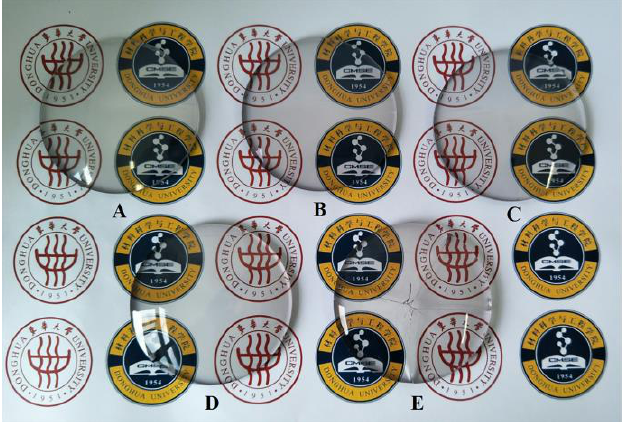
Figure 14. Impact resistance of hardened coating (Note: A, B, C, D, E are sample 1:1, 1:2, 1:3, 1:5, 0:1, in sequence).